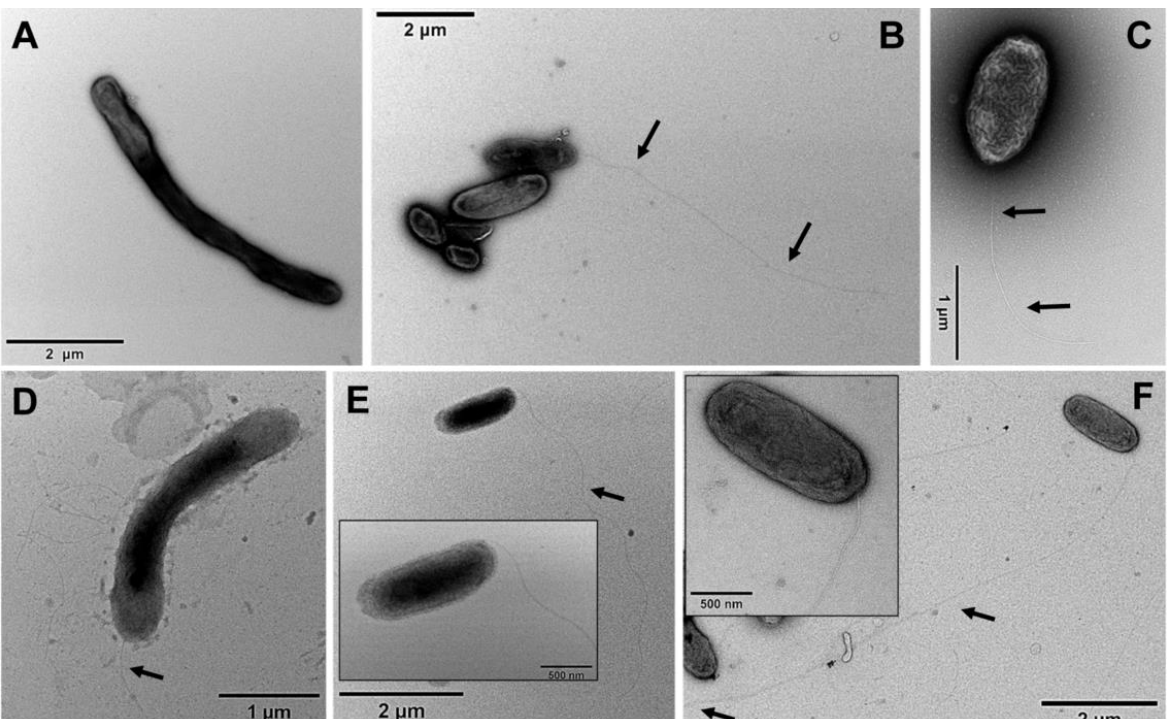
Figure 3. Transmission electron microscopy images of G. phototrophica and G. groenlandica cells grown in with and without CaCl 2 . ( A ) Cells of G. phototrophica in 2 mg CaCl 2 L −1 were long rod shaped without flagella. ( B ) Cells of G. phototrophica in 20 mg CaCl 2 L −1 were short rod shaped with polar flagella. ( C ) Cells of G. phototrophica in 50 mg CaCl 2 L −1 were rod shaped with flagella. ( D ) Cells of G. groenlandica in 2 mg CaCl 2 L −1 were rod-like and elongated in shape with short flagella. ( E ) Cells of G. groenlandica in 20 mg CaCl 2 L −1 were rod shaped with flagella. ( F ) Cells of G. groenlandica in 50 mg CaCl 2 L −1 were rod shaped with long flagella. Scale bar is included in each figure. Inlet shows the close-up images. Arrows show the flagella.